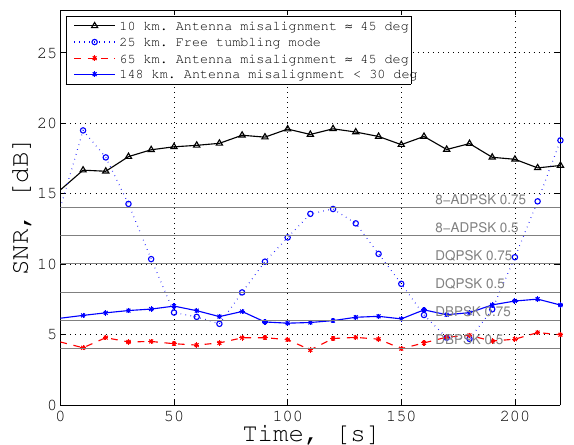
Figure 16. Measured SNR for various distances and pointings within an ISL session [25].